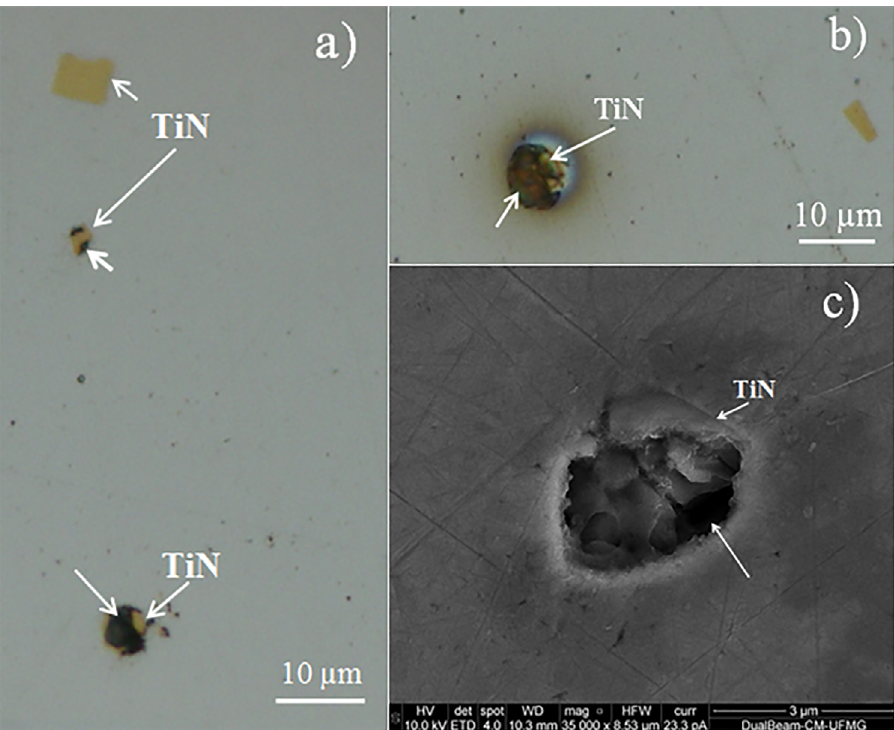
Figure 12. (a, b) Optical micrographs and (c) SEM images of tempered sample surface immersed in 0.1 mol/L NaCl during 86400s. Pit locations are indicated by white arrows in micrographs.